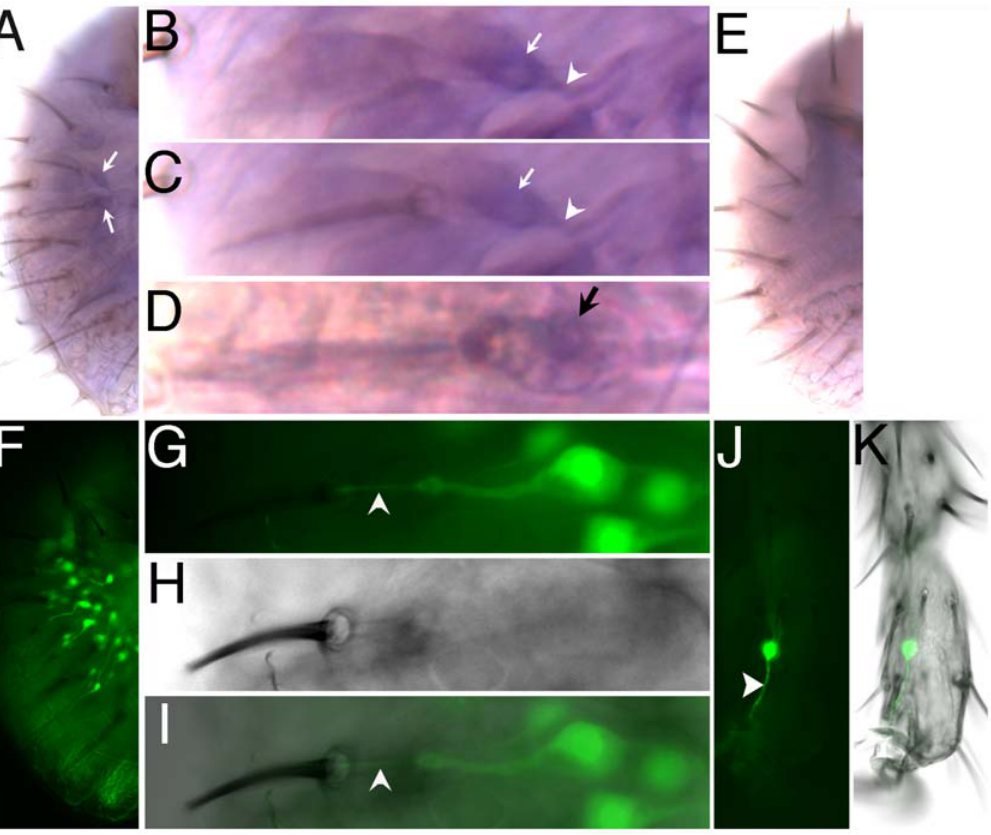
Figure 5. mtt is present in chemosensory sensilla. (A–D) and (E) show mtt in situ hybridization on WT and Df(2R)Ex7096 mtt mutant labellum, respectively. (A) In WT labellum, single cells (arrows indicate two single cells in focus) are labeled by the mtt riboprobe. (A) is a composite image of one image focusing on the labeled cells and one image focusing on the chemosensory bristles. (B) and (C) are high-magnification views of one sensilla visible in (A) (upper arrow). (B) focuses on the labeled cell. (C) is a composite image of (B) and a different focal plane in which the nearby chemosensory bristle is visible. Note that one single neuron-like cell (indicated by an arrow) is labeled near the chemosensory bristle visible in (C). This cell is likely a neuron, as an axon is weakly visible (indicated by an arrowhead). (D) shows another sensilla with a different Nomarski setting illustrating that the single labeled cell (indicated by a black arrow) is present in a chemosensilla housing at least five cells. (E) No signal is detected on Df(2R)Exel7096 mutant labellum. (E) is a composite image of one image focusing within the labellum and one image focusing on the chemosensory bristles. (F–I) Labellum of NP4288-GAL4/UAS-nlsGFP showing the GFP-expressing taste neurons. (F) In one labial palp, around 28 GRNs are present (see also Figure S3). (I) is a composite image of the fluorescent and bright-field images shown in (G) and (H), respectively. Arrowhead in (G and I) indicates the dendrite innervating the taste bristle sensilla. (J and K) NP4288-GAL4/UAS-mCD8GFP double homozygous foreleg showing that taste neurons are labeled in the tarsi. Arrowhead in (J) indicates the dendrite of the taste neuron. Note that only one of the two labeled neurons is visible at this focal plane. (K) is a composite image of the fluorescent and bright-field images.